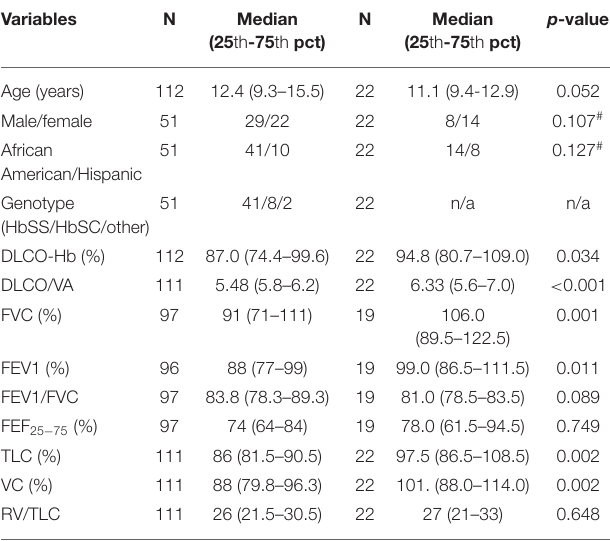
TABLE 1 | Baseline characteristics of the study